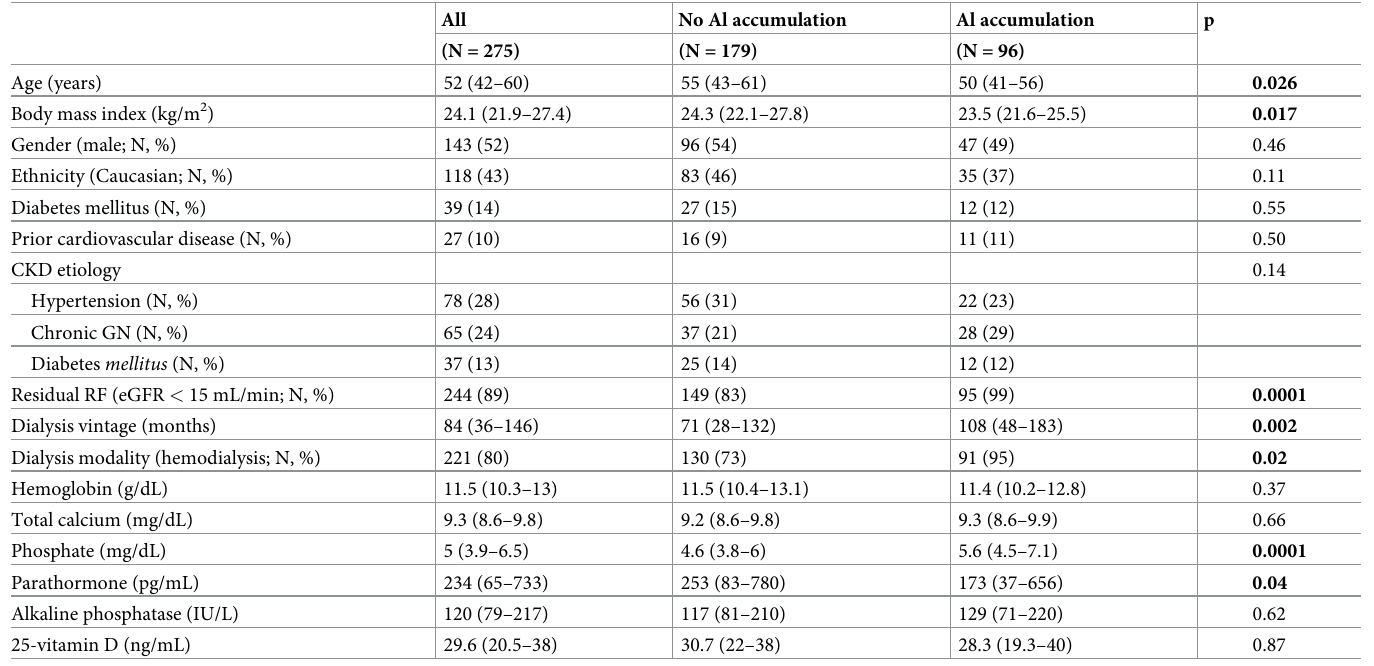
Table 1. General clinical and biochemical data according the diagnosis of bone aluminum (Al) accumulation.